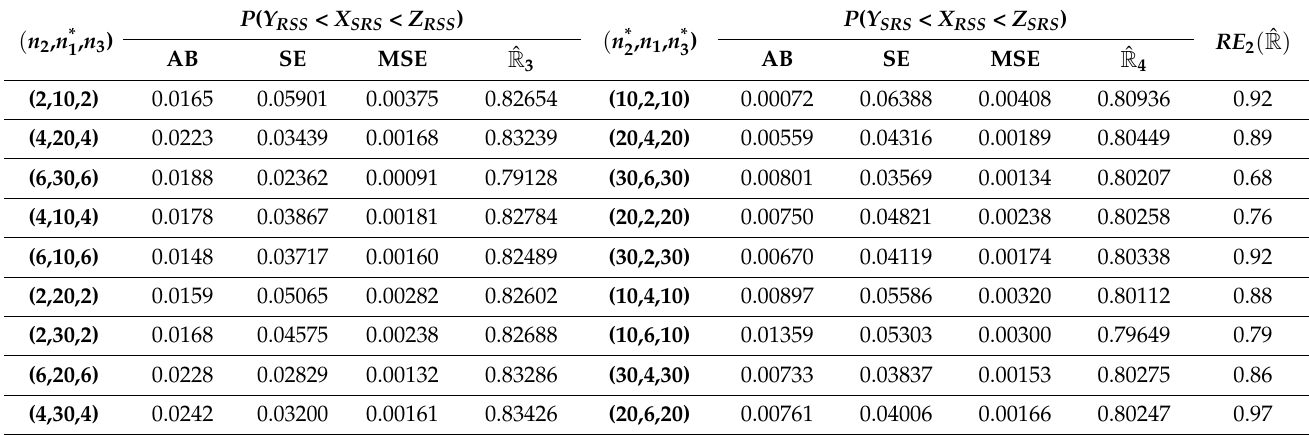
Table 4. Measurements of ˆ R 3 and ˆ R 4 for different sampling schemes at R = 0.81 and d = 5.